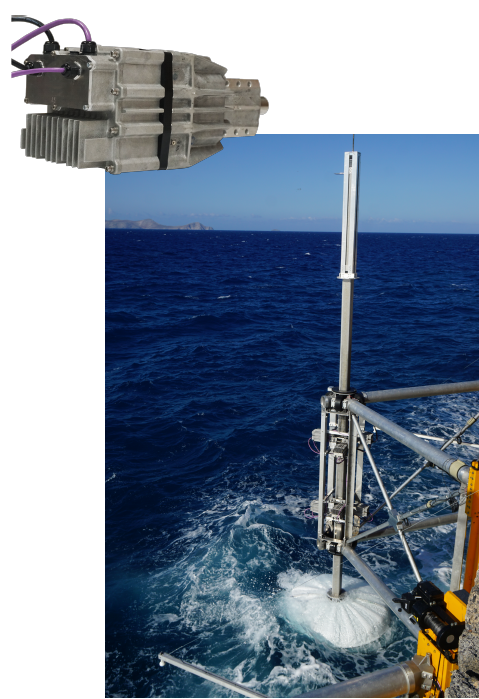
Figure 1. Picture of the SINN Power GmbH prototype in Crete and the analysed generator